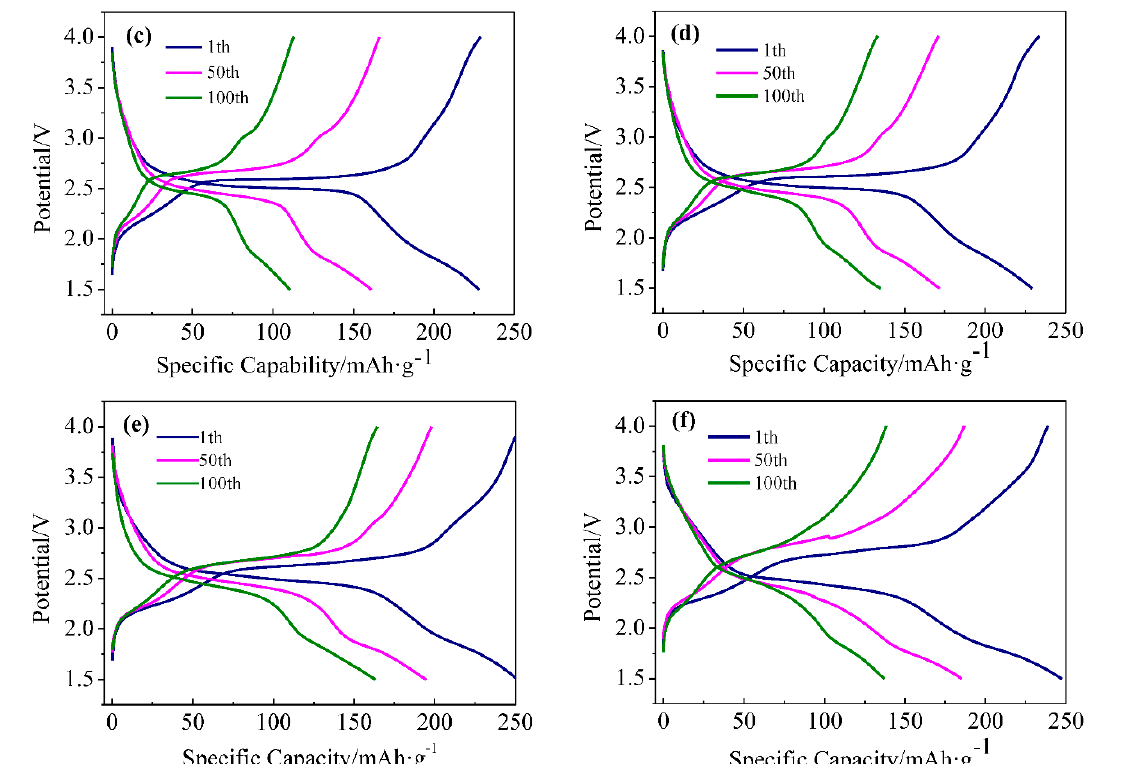
Figure 3. ( a ) Cycling performance and ( b – f ) selected charge/discharge curves of Ni 0 , Ni 1 , Ni 2 , Ni 3 , and Ni 4 samples at a current density of 32.4 mA/g.